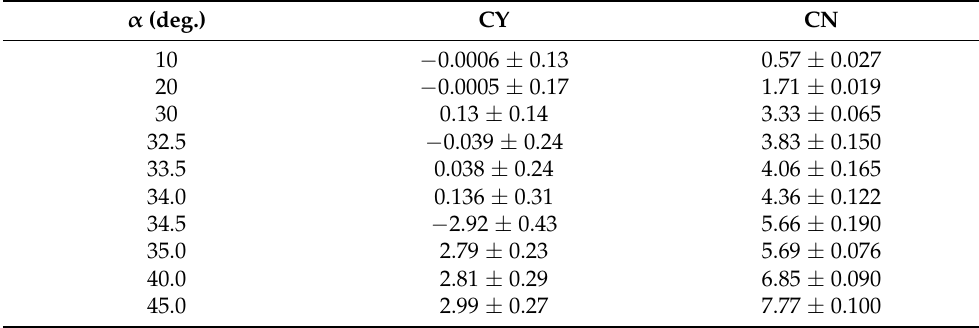
Table 2. Side and normal force coefficients versus angle of attack: Ma = 0.2, Re = 2 × 10 6 . Grid S1. α